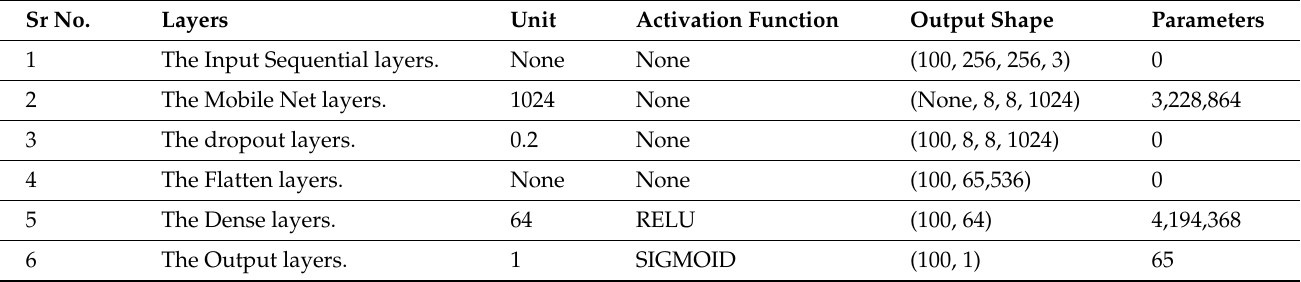
Table 4. The Mobile Net model configuration parameters and layer architectural analysis.